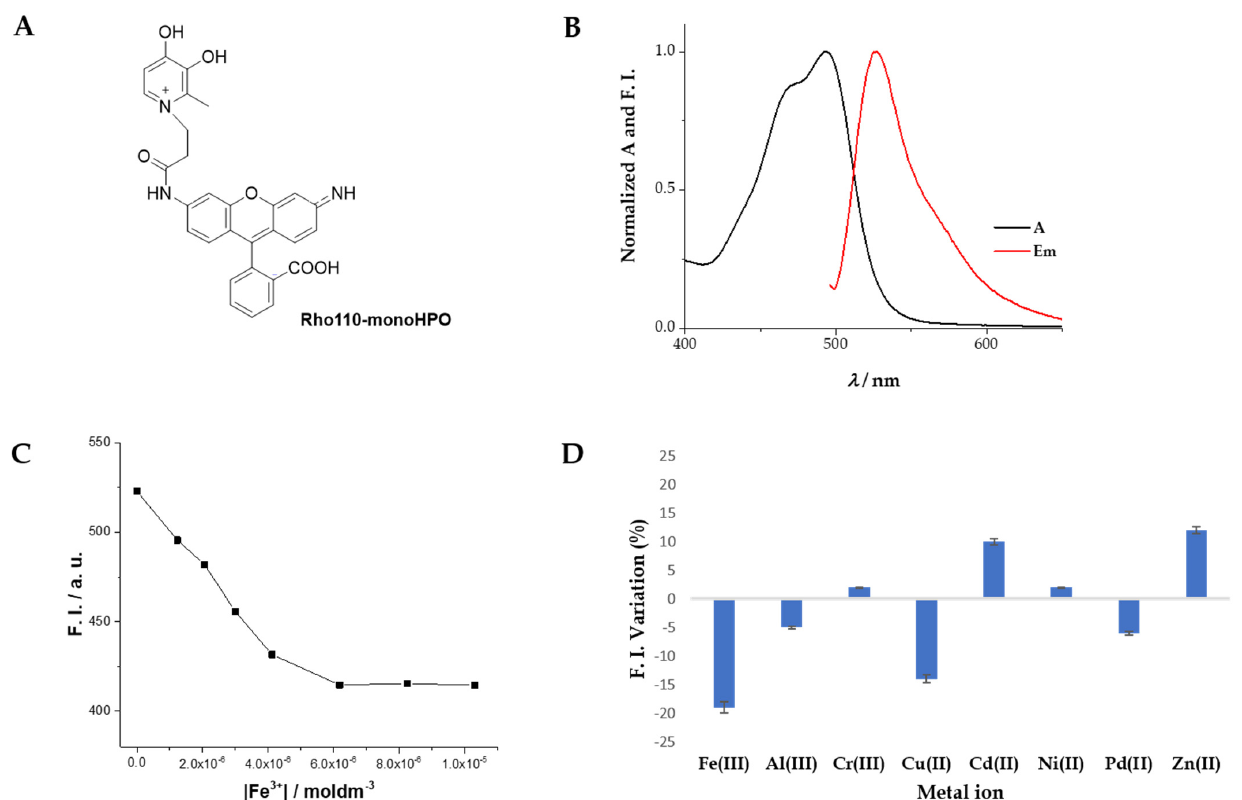
Figure 3. ( A ) Structure of the hydrochloride salt of Rho110-monoHPO ; ( B ) Normalized absorption and emission spectra in MOPS pH = 7.40 of Rho110-monoHPO , at 25 °C; ( C ) Fluorescence decrease with increasing Fe(III) concentrations (aqueous solution, pH = 5), [ Rho110-monoHPO ] = 1.0 × 10 − 5 M; ( D ) Fluorescence intensity variation (%) for the metal ions studied (Fe(III), Al(III), Cr(III), Cu(II), Cd(II), Ni(II), Pd(II), and Zn(II) with Rho110-monoHPO , in deionized water (pH = 5) at 25 °C [ Rho110-monoHPO ] = 1.0 × 10 − 5 M; 1:1 ( Rho110-monoHPO :metal ion).